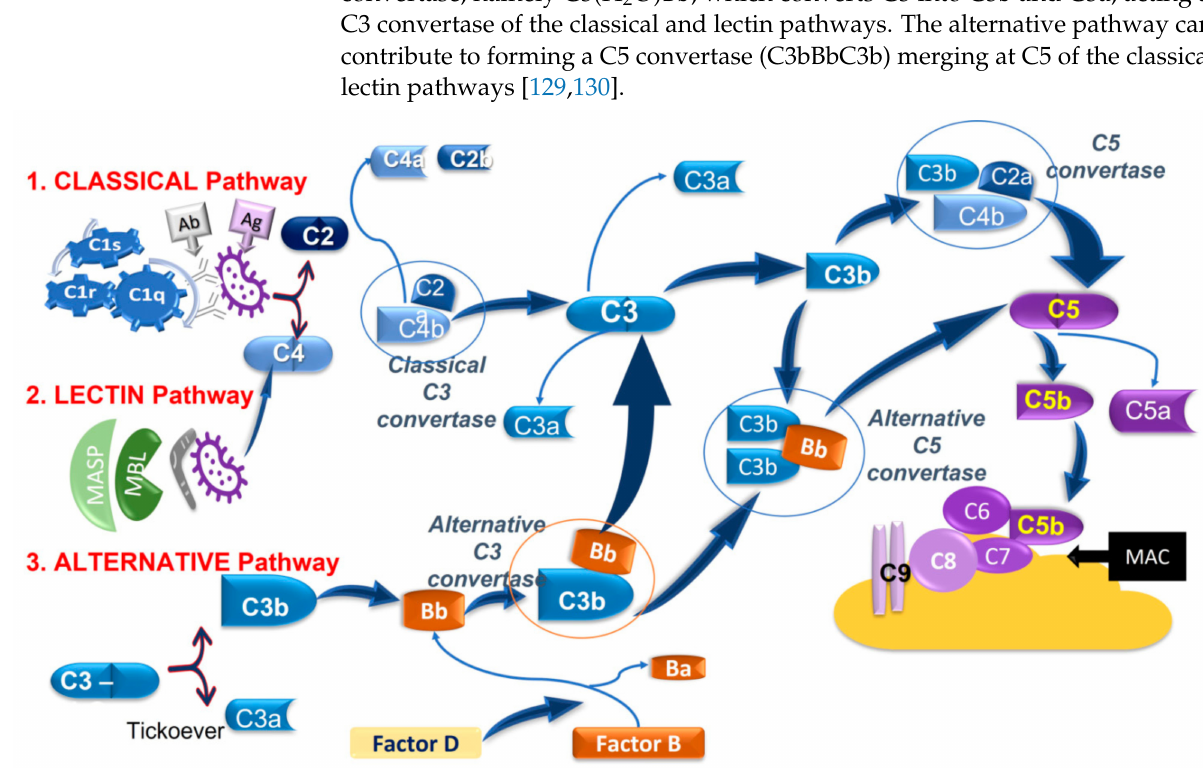
Figure 2. The Complement pathway: three pathways activate the Complement cascade, and they converge within